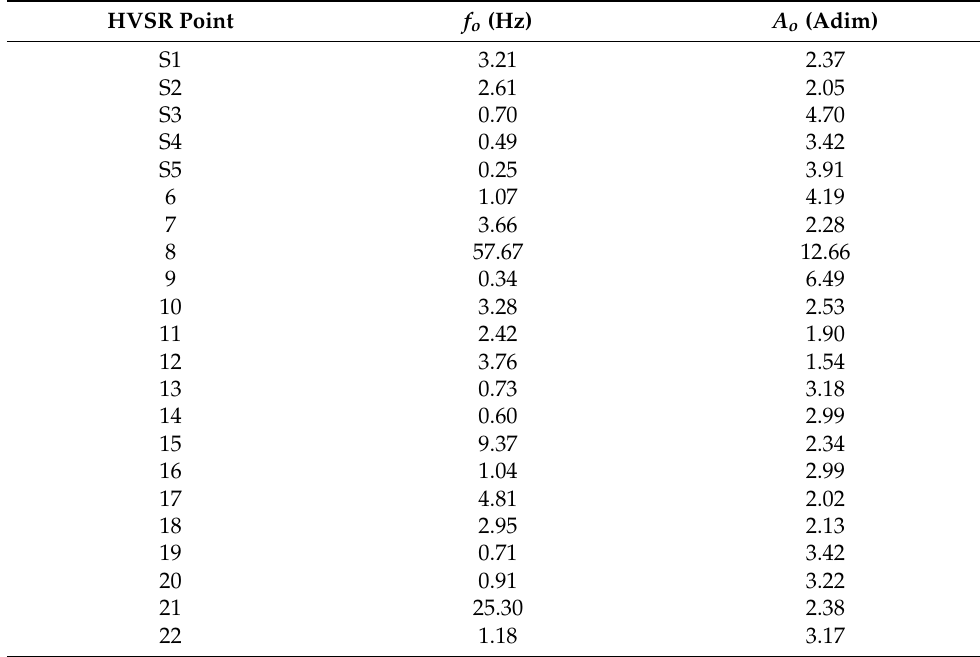
Table 2. Results obtained in the interpretation of the HVSR tests ( f o Hertz, A o dimensionless). HVSR